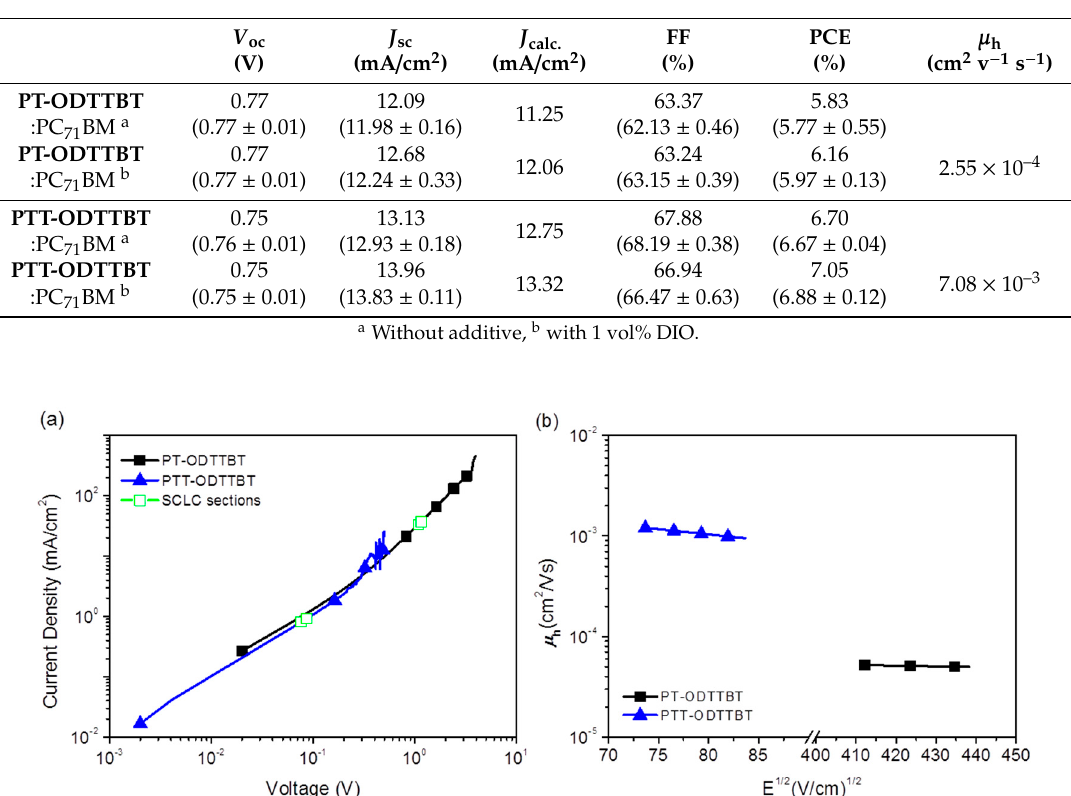
Figure 2. ( a ) J-V characteristics of blended films with and without DIO and ( b ) the corresponding EQE curves. Table 2. Photovoltaic properties of polymer:PC 71 BM-based OPV devices.